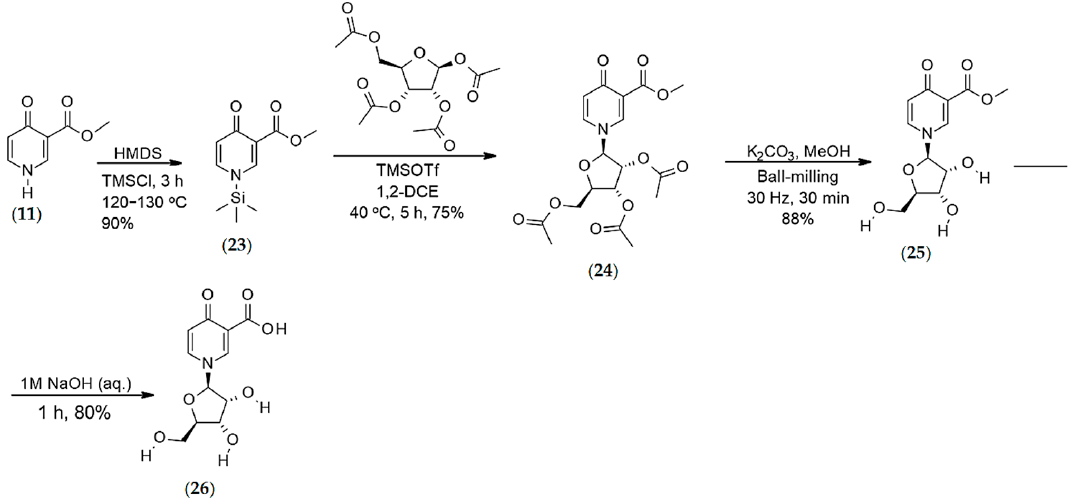
Scheme 7. Synthesis of the methyl-ester and carboxylate ribosyl